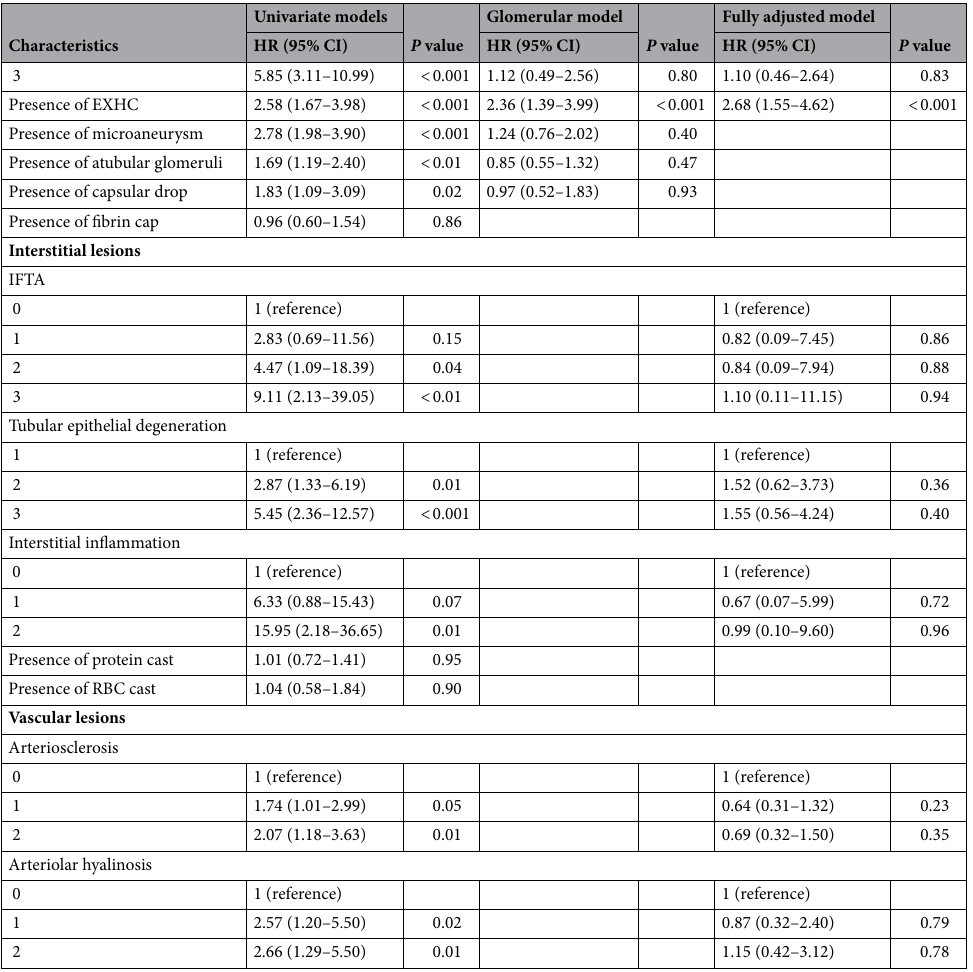
Table 2. Univariable and multivariable Cox proportional hazard models for progression to end-stage renal disease in patients with type 2 diabetes mellitus. For Cox analyses, classes I and IIa were collapsed together as the reference group for RPS glomerular class. Scores of 2 and 3 were collapsed together as 2 for solidified glomerulosclerosis and not otherwise specified glomerulosclerosis. Scores of 3 and 4 were collapsed together for Kimmelstiel–Wilson nodules, glomerular capsular adhesions, and periglomerular fibrosis. Scores of 2, 3, and 4 were collapsed together for segmental sclerosis. HR, hazard ratio; DR, diabetic retinopathy; SBP, systolic blood pressure; eGFR, estimated glomerular filtration rate; RAAS: renin–angiotensin–aldosterone system; RPS, Renal Pathology Society; GS, glomerulosclerosis; KW, Kimmelstiel–Wilson; EXHC, extracapillary hypercellularity; IFTA, interstitial fibrosis and tubular